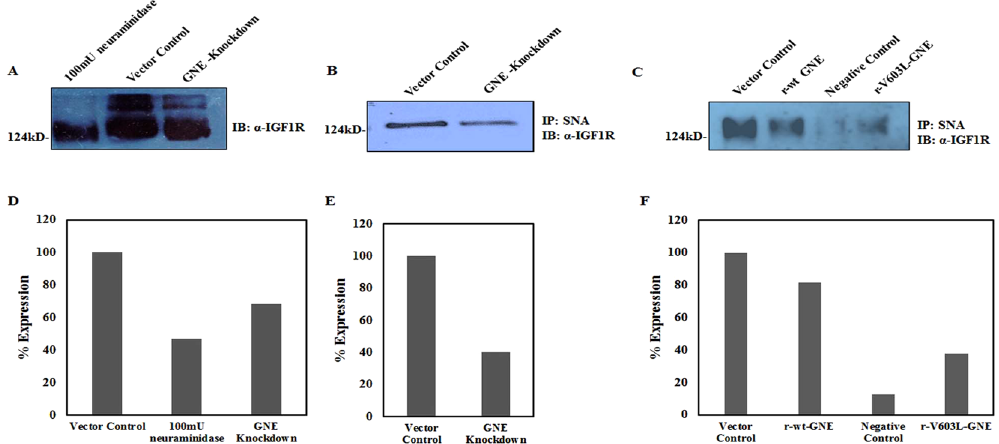
Figure 2. Determination of IGF-1R sialylation levels using Lectin affinity assay: ( A ) Sialylation status of IGF-1R: Equal amount of cell lysates from vector control cells were treated with 100 mU of C. perfringen s sialidase and untreated lysates from GNE knockdown cells were separated on 8% SDS-PAGE followed by immunoblotting with anti- α IGF-1R. ( B ) SNA Lectin affinity assay: Sialylated IGF-1R from GNE knockdown cells and scrambled shRNA vector control cell was pulled down using biotin labelled SNA/streptavidin-coupled agarose and immunoblotted with anti- α IGF-1R. ( C ) Sialylated IGF-1R complexes from GNE mutant and pcDNA3 transfected vector control cells were pulled down using biotin labelled SNA/streptavidin-coupled agarose and immunoblotted with anti- α IGF-1R. Sialylated IGF-1R complexes from 100 mU neuraminidase treated vector control cells that were pulled down using biotin labelled SNA/streptavidin-coupled agarose served as negative control in this experiment. Equal amount of protein was used as input lysates. ( D – F ) are showing representative densitometry graphs of ( A – C ), respectively, normalized to vector control.